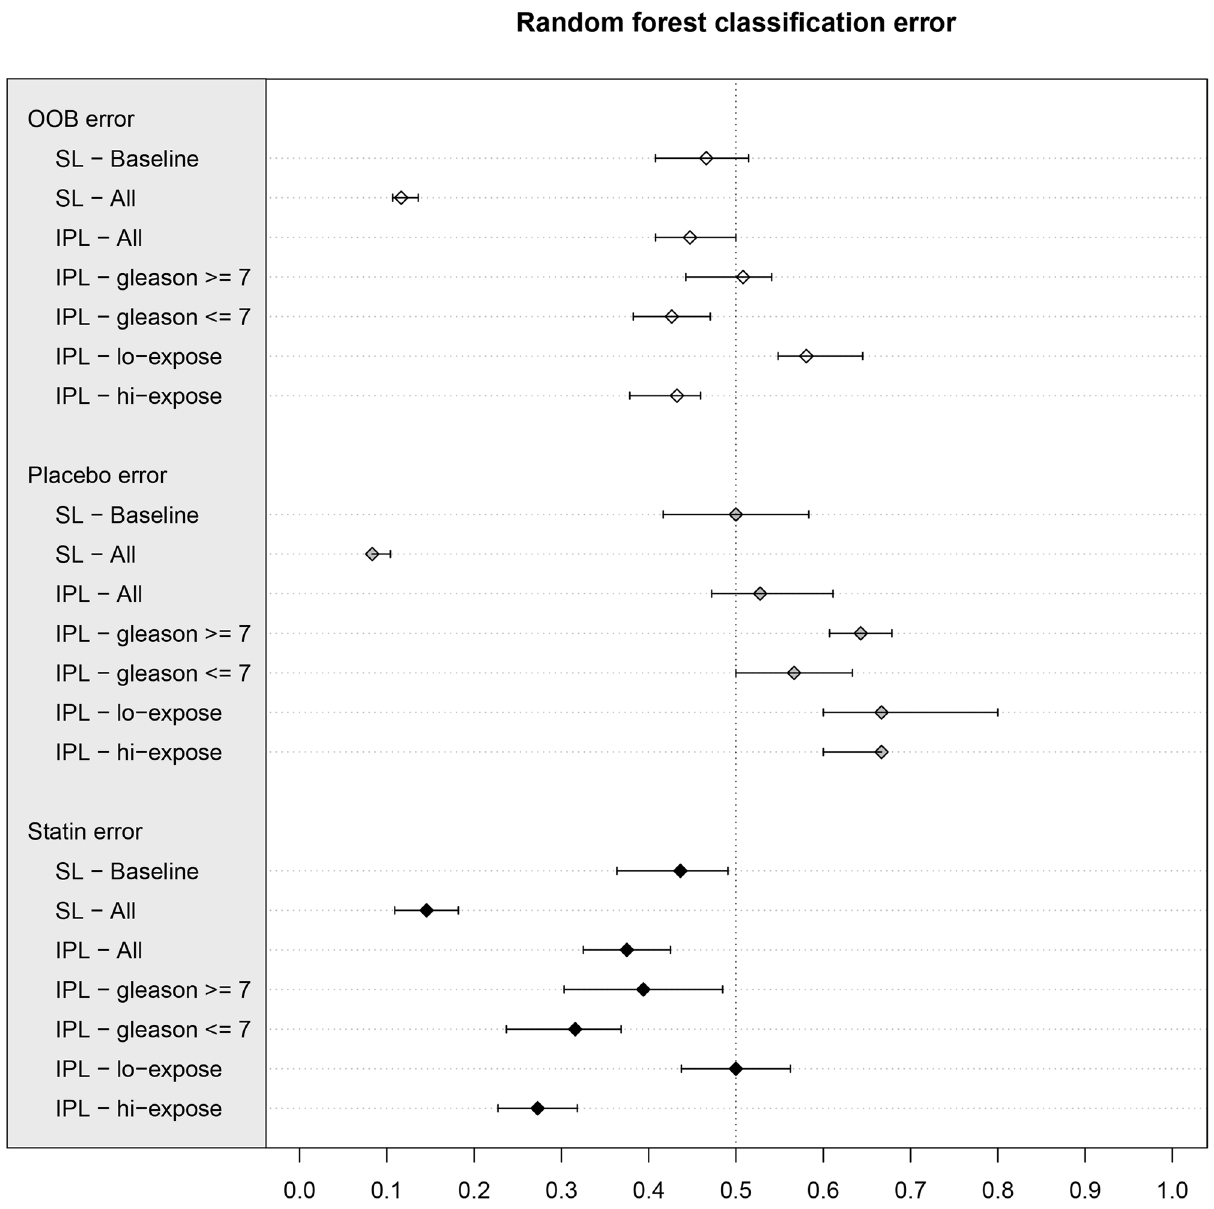
Figure 4. Summary of all RFC model results depicted as a forest plot. The diamonds correspond to the point estimates (median) of each model: white for out-of-bag classification error; grey for placebo group classification error; black for statin group classification error, whereas the bars represent the estimated 95% confidence interval of the corresponding classification error. The vertical dashed line represents the 50% classification error, which is considered as random. OOB error and estimated 95% confidence interval below 50% indicates that the classifiers perform better than random. The serum lipid and lipoprotein lipids (SL) after the statin intervention performs extremely well as the classifier, whereas the intraprostatic tissue lipidome (IPL) performs barely below the 50% line. Remarkably, in each intraprostatic lipidome model, the statin arm in much better classified in comparison to the placebo arm. Intraprostatic lipidome (IPL) does not discriminate the study arms among men with Gleason 7-and-above, whereas it does separate the study arms among men with Gleason 7-and-below. The intraprostatic lipidome (IPL) cannot make a distinction between the study arms in below-27-days (lo-expose) statin use sub-population, while it does discriminate the study arms among men who used stains more than 27 days